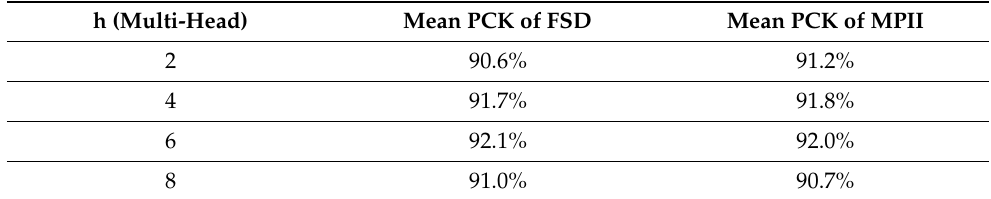
Table 7. Mean PCK of different attention head counts in FSD and MPII